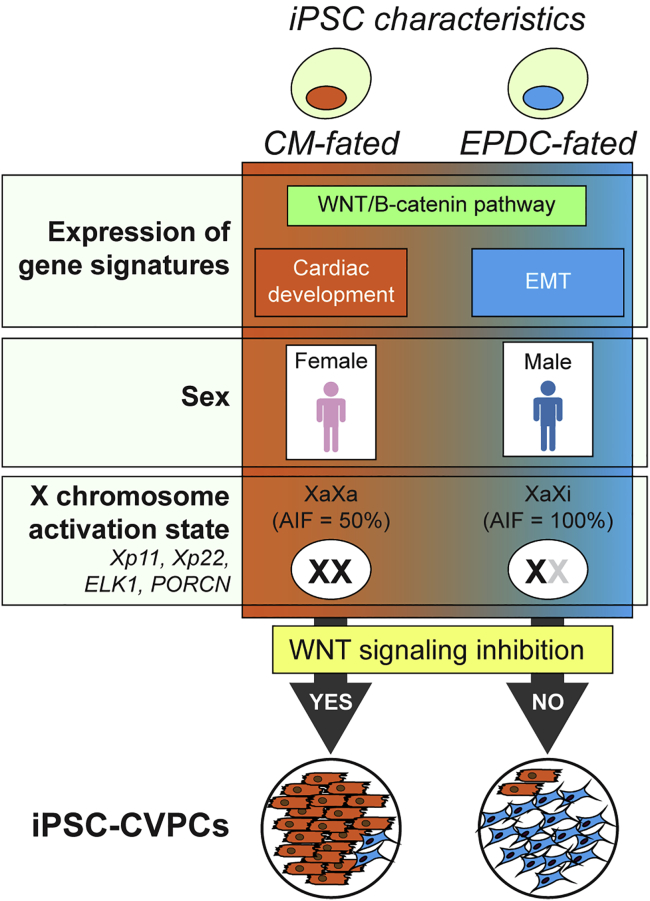
iPSC Characteristics that Influence Their Cardiac-Fate DeterminationCartoon showing iPSC characteristics that influence their cardiac-fate determination, including: (1) the expression levels of 91 genes grouped into three gene signature classes (WNT/B-catenin pathway, cardiac development genes, and genes involved in EMT); (2) sex: female iPSCs are more likely to differentiate to CMs than males; and (3) X chromosome activation state: female iPSCs that have activated both X chromosomes (XaXa) are more likely to differentiate to CMs.